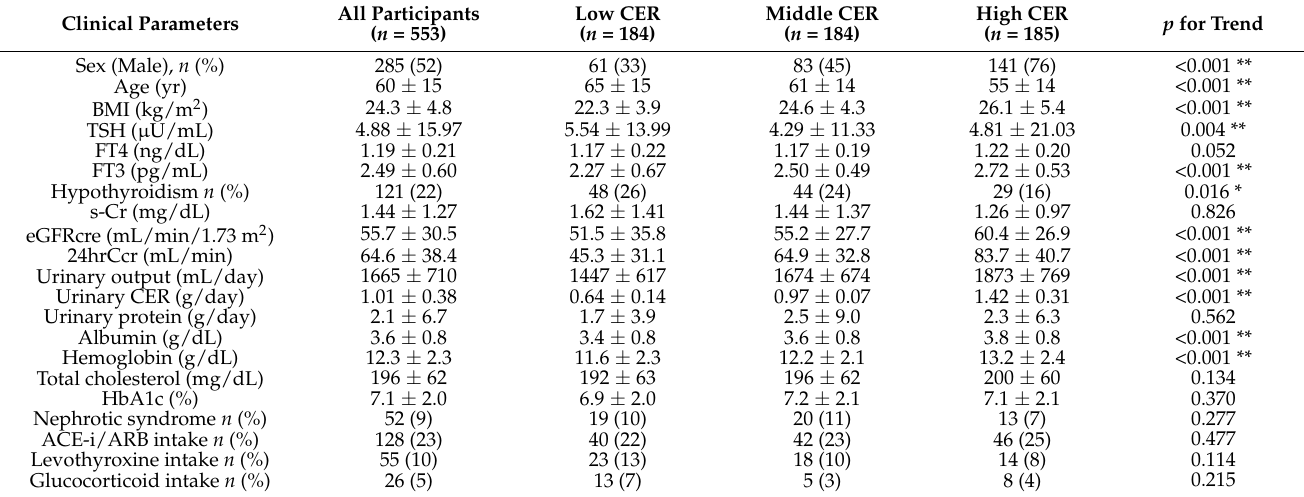
Table 1. Characteristics of study participants stratified by tertiles of urinary creatinine excretion.